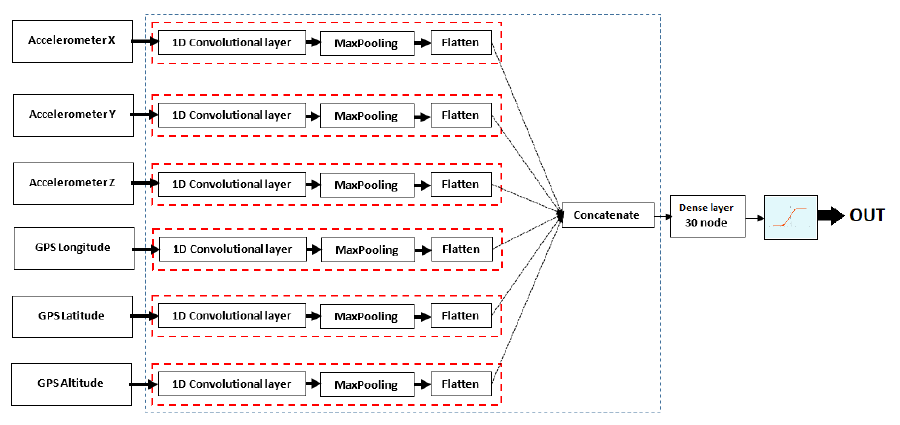
Figure 9. One-dimensional convolutional neural network (1D-CNN) model architecture.